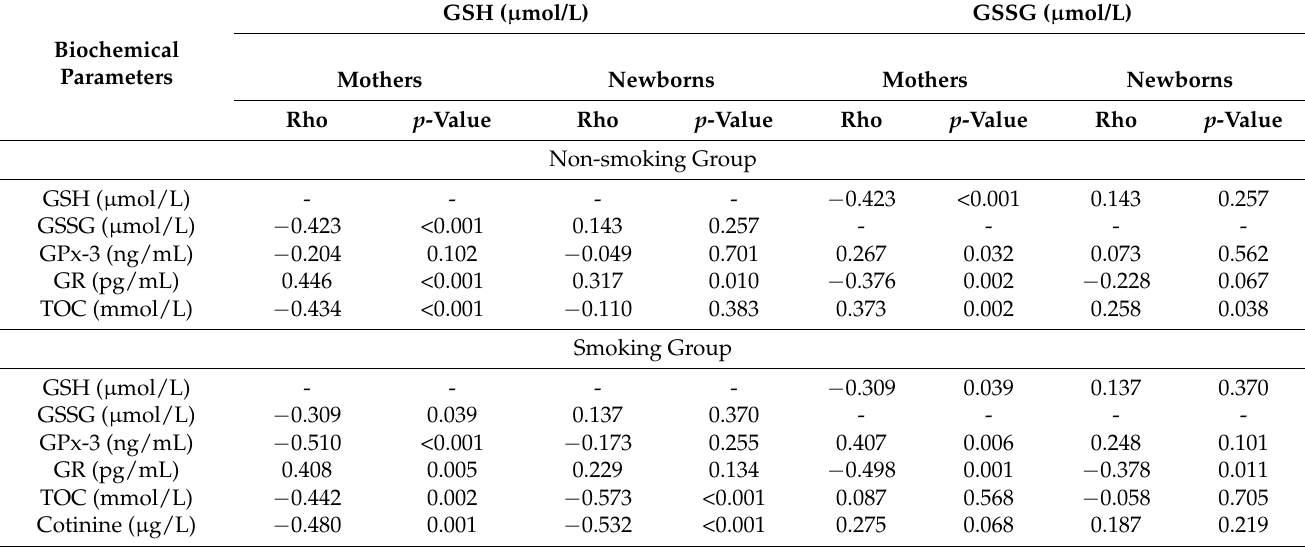
Table 1. Spearman’s rank correlation coefficients between GSH as well as GSSG and other studied biochemical parameters in non-smoking and smoking mother-newborn pairs.